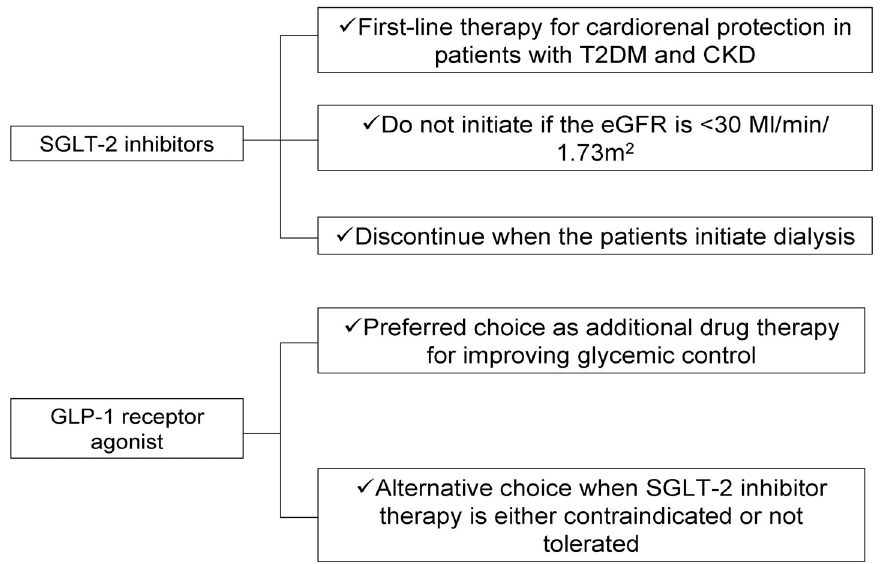
Figure 1. Key clinical practice recommendations for the use of SGLT-2 inhibitors and GLP-1 receptor agonists in patients with diabetic kidney disease.